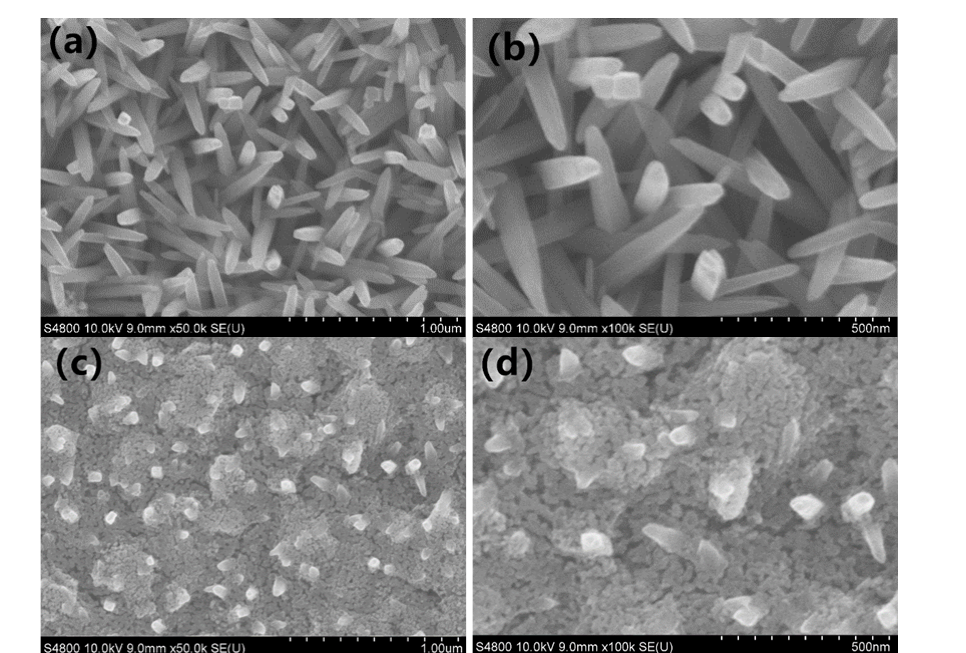
Fig. 1. SEM image of (a,b) TiO 2 nanocones, (c,d) Co 3 O 4 @TiO 2 photoelectrode.